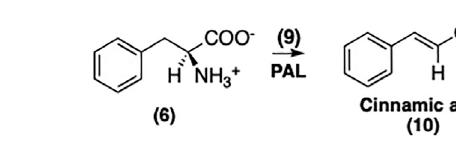
Frontiers in Chemistry |